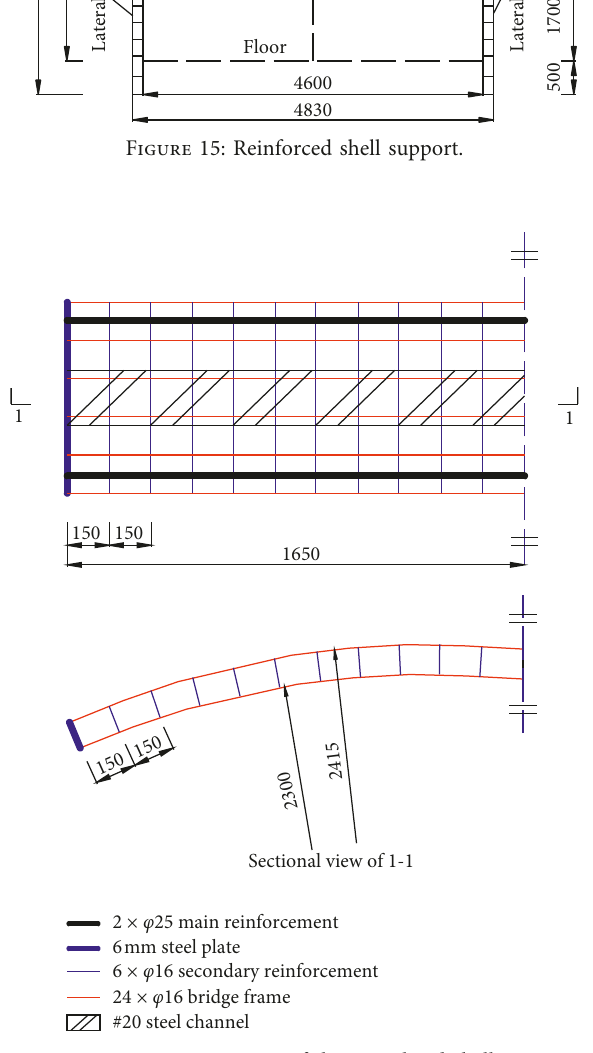
Figure 16: Structure of the reticulated shell.